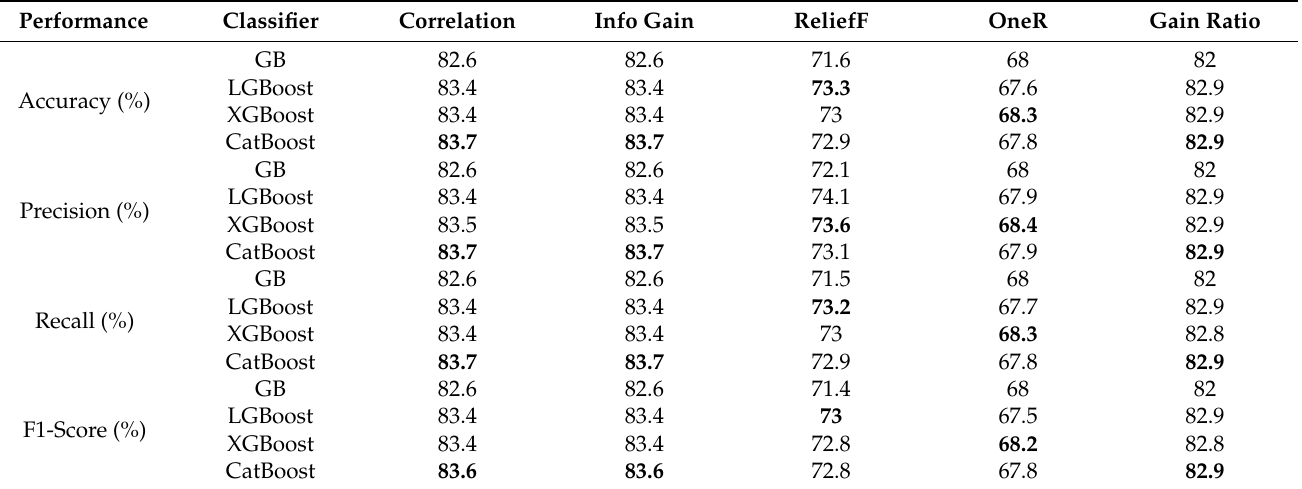
Table 8. Results of models with respect to Random Oversampling and feature selection technique.